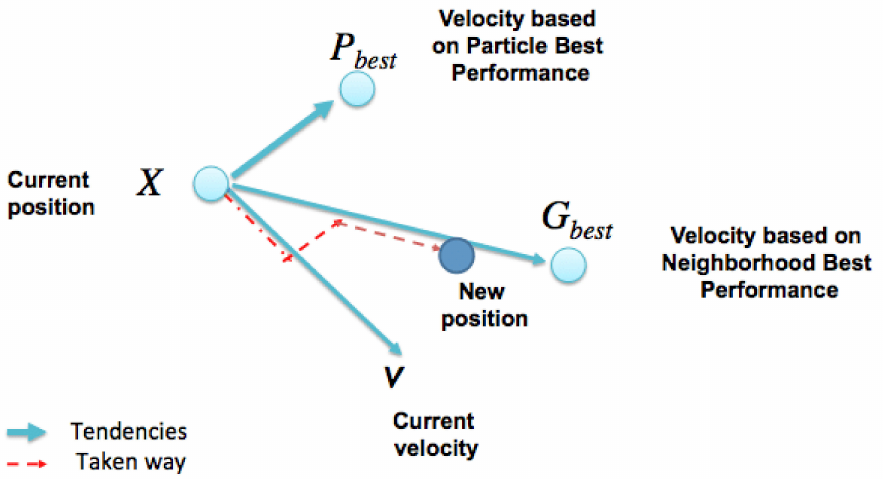
Figure 4. The motion pattern in the particle swarm algorithm